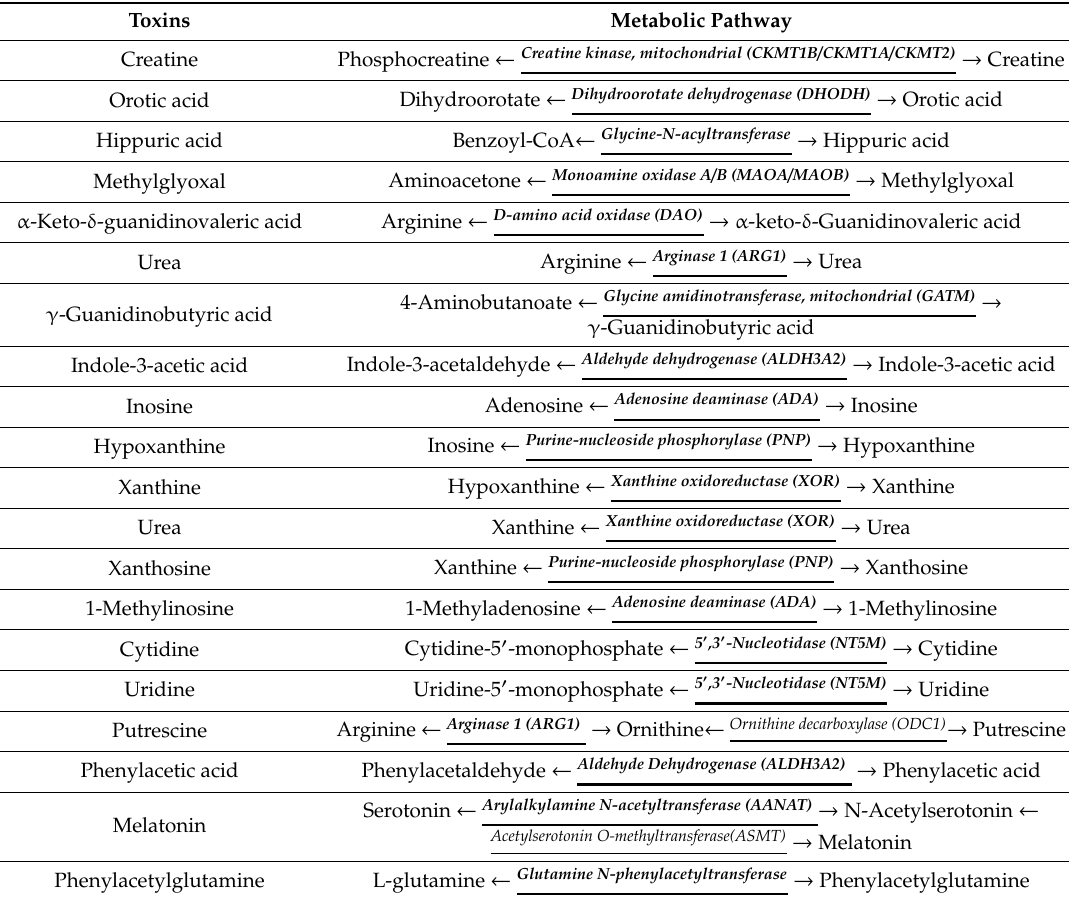
Table 1. Bioinformatically identified uremic toxins, which are metabolically connected to mitochondria. Pathways were identified through the analysis of the KEGG database [45]. Enzymes are highlighted in italic, enzymes that have a mitochondrial localization are highlighted in bold, and arrows indicate direction of